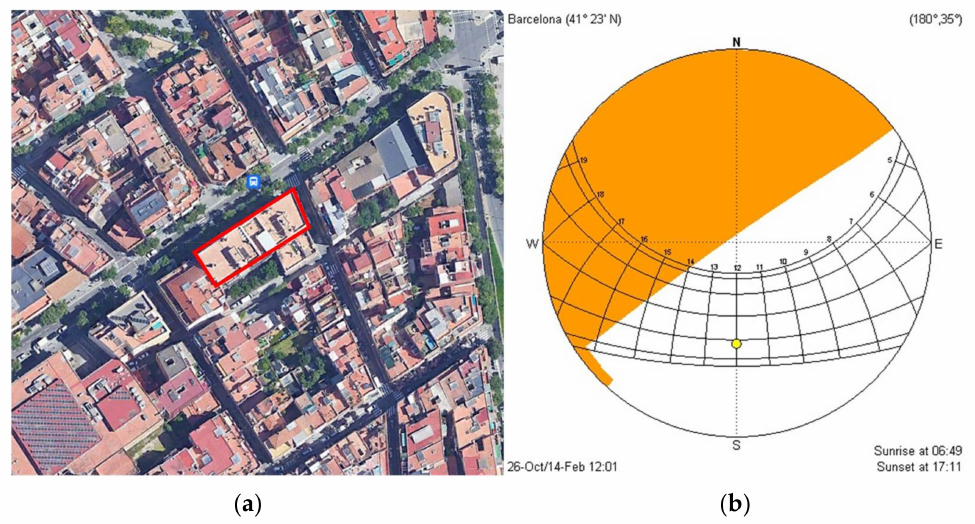
Figure 1. El Carmel district, ( a ) Dw1’s position and ( b ) the stereographic view from Dw1’s window.